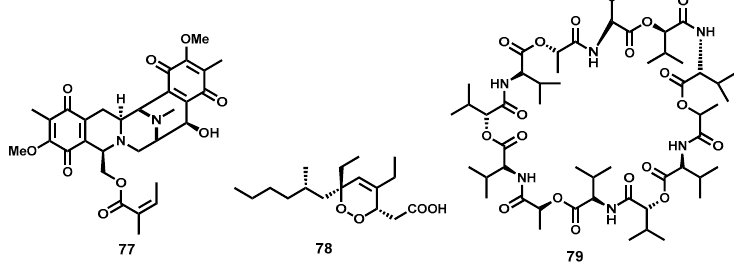
Figure 11. Marine-derived antileishmanial natural products.